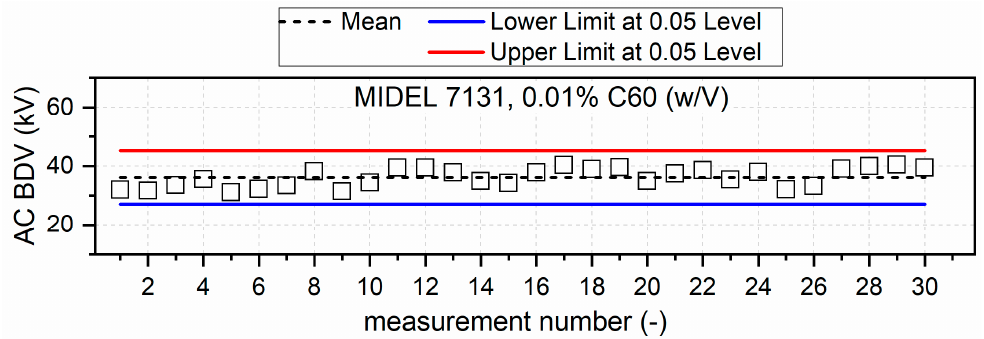
Figure 8. Graphical representation of Grubb’s test of sample 1_SE. Red and blue lines represent limit values of AC BDV at alpha 0.05 and individual measurements are marked as square symbols. The dotted line represents the mean value of AC BDV of the tested